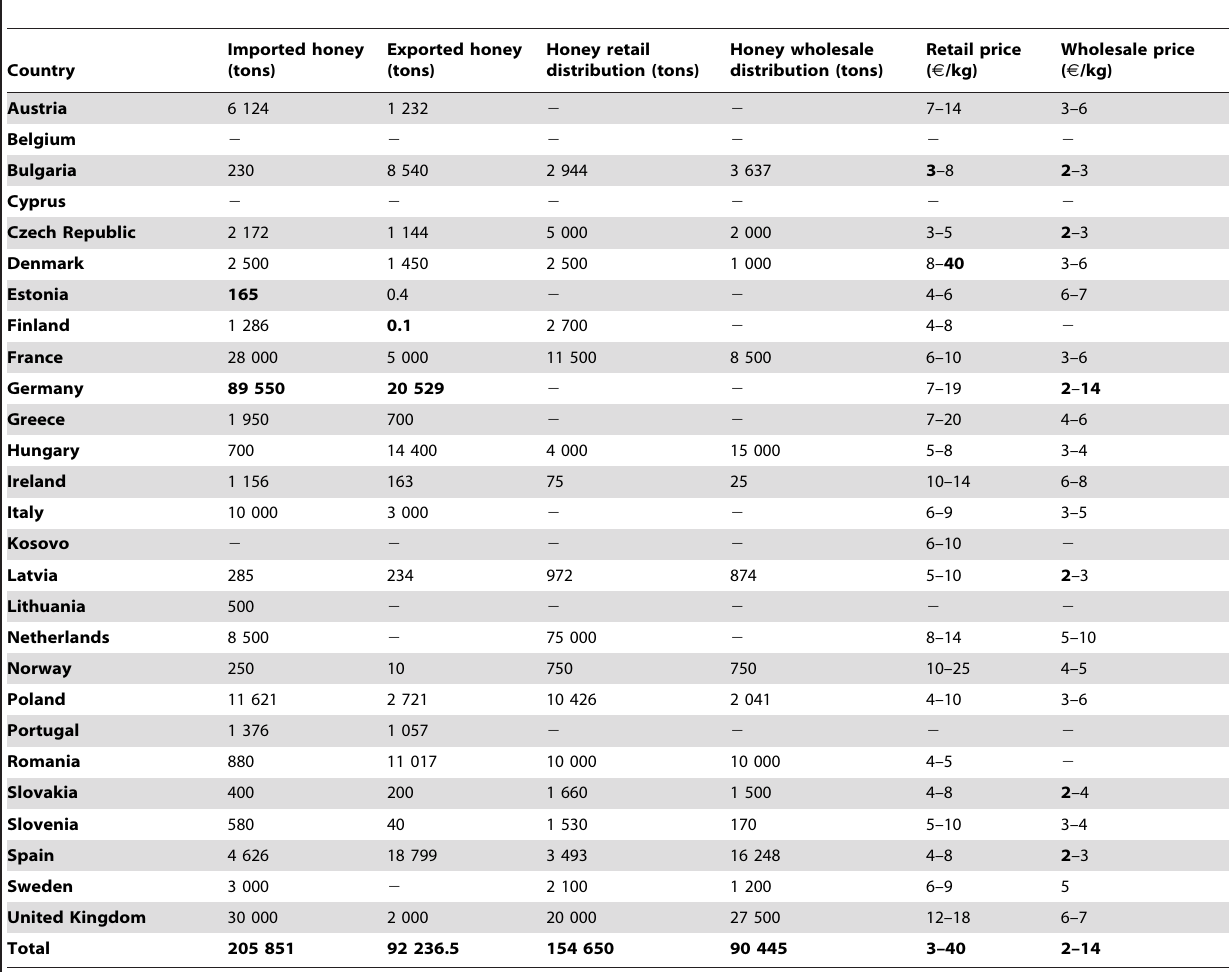
Table 5. Trade of honey: quantity of honey imported into and exported from the European Union; volume of honey sold through retail or wholesale distribution and price range for honey in Europe in 2010.